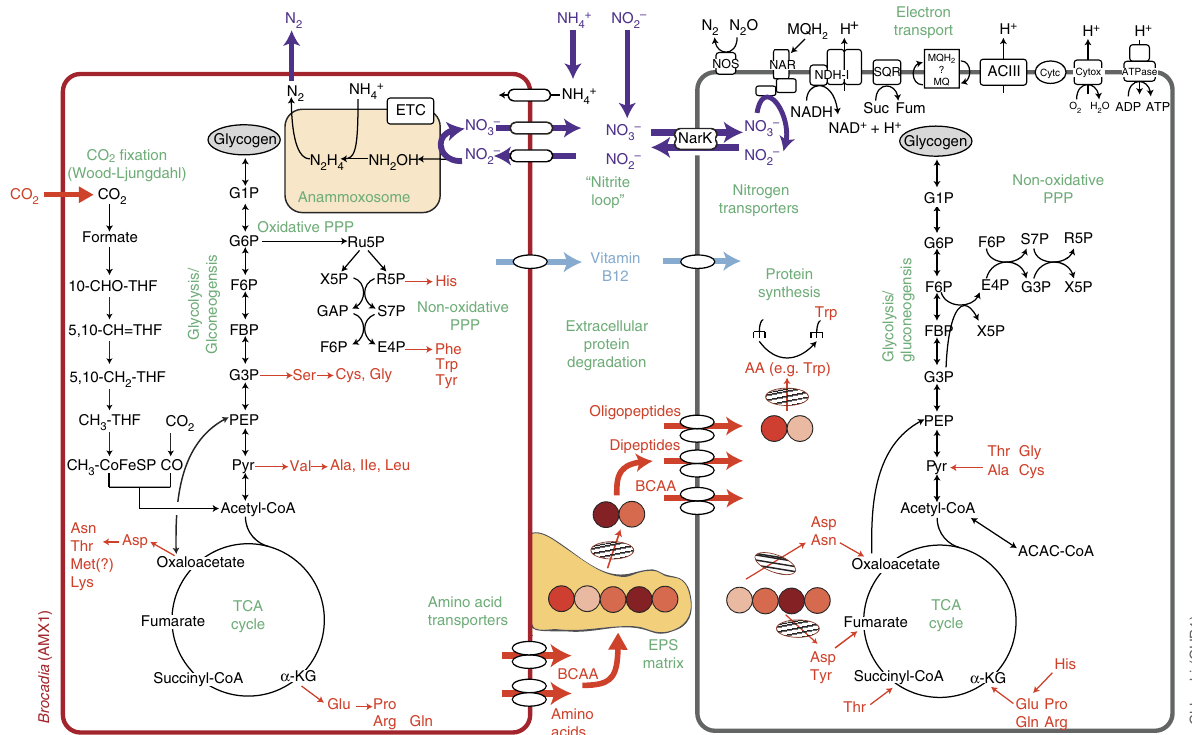
Figure 7 | Proposed metabolic interactions between Brocadia (AMX1) and Chlorobi (CHB1) in anammox granules. AMX1 fixes CO 2 and synthesizes amino acids and EPS. CHB1 degrades proteins bound in EPS using extracellular peptidases and subsequently transports and catabolizes short peptides (circles) to central carbon intermediates. Nitrite oxidation and reduction by AMX1 and CHB1, respectively, results in a distributed nitrite loop. Purple arrows indicate nitrogen cycling; orange arrows indicate carbon cycling; light blue arrows indicate vitamin B metabolite exchange. Hatched ovals indicate peptidases. BCAA, branched-chain amino acids. Met(?), methionine synthase present in genome but other steps involved in Met biosynthesis not identified. The presence of a periplasm has been ignored for clarity of the